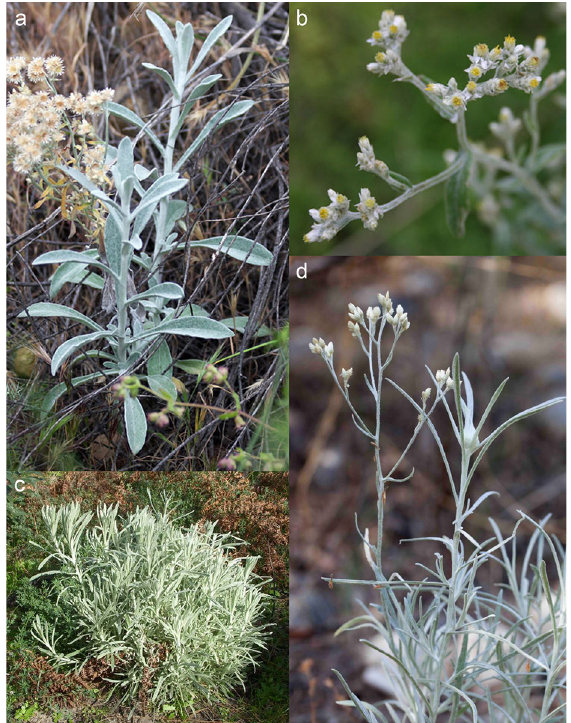
Figure 2. Pseudognaphalium canescens. a. Habit; b . Detail of the inflorescence. c, d. Pseudognaphalium beneolens. c . Habit; d . Detail of the habit. (Photographs: a, b. John Avise, Asteraceae of Orange Co., California; C. Neal Kramer, CalPhotos- University of California, Berkeley; d. Michael Mitchell,